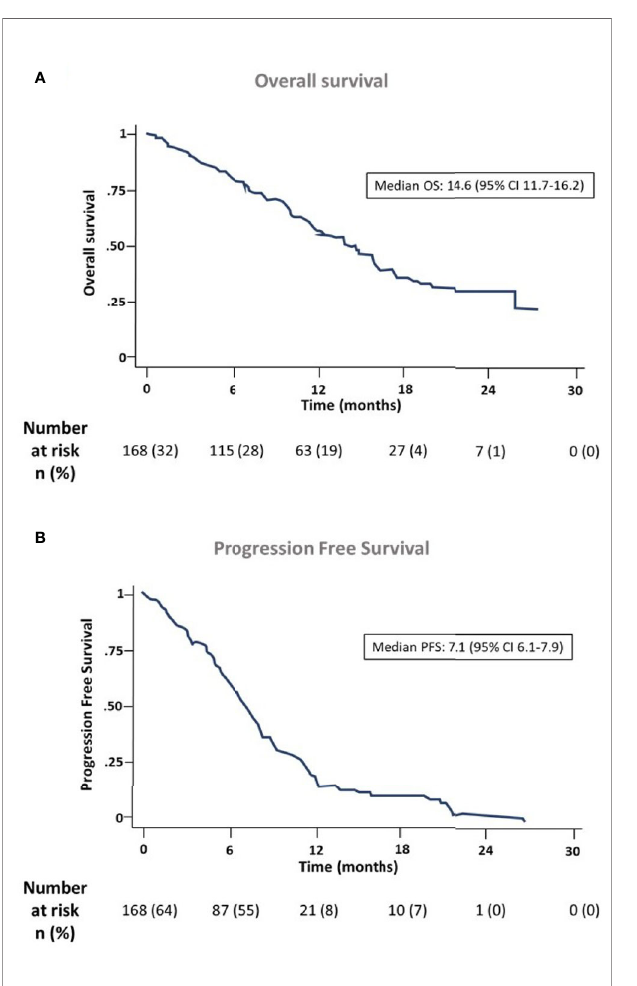
FIGURE 1 | Overall survival (A) and progression-free survival (B) of the ANGIOMET cohort.